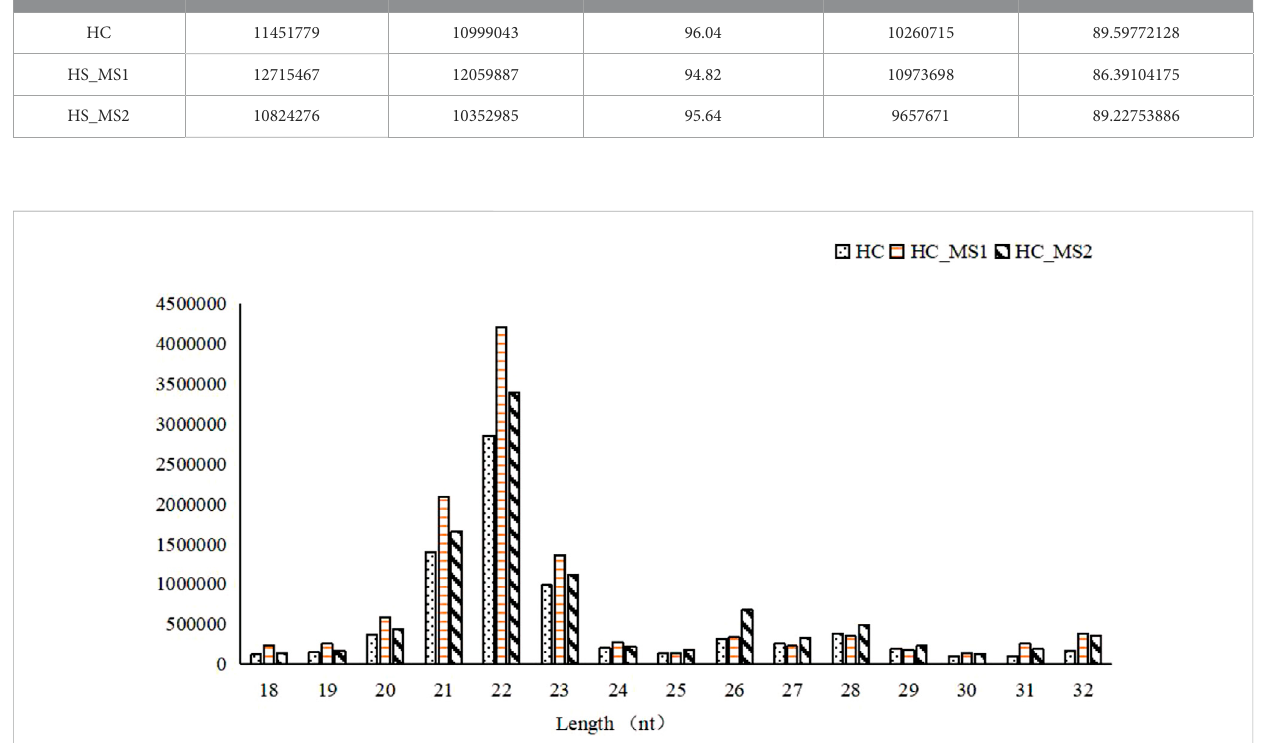
FIGURE 1 Length distribution of small RNAs in the three groups (n =